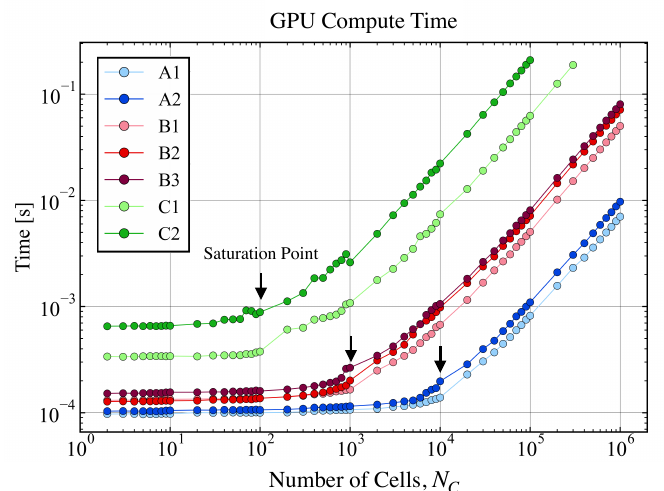
Figure 4. Absolute compute time (time-to-solution) as a function of cell number N C for the GPU evaluation of the species source terms for the mechanisms listed in Table 1. Saturation points for each mechanism group are indicated by the black